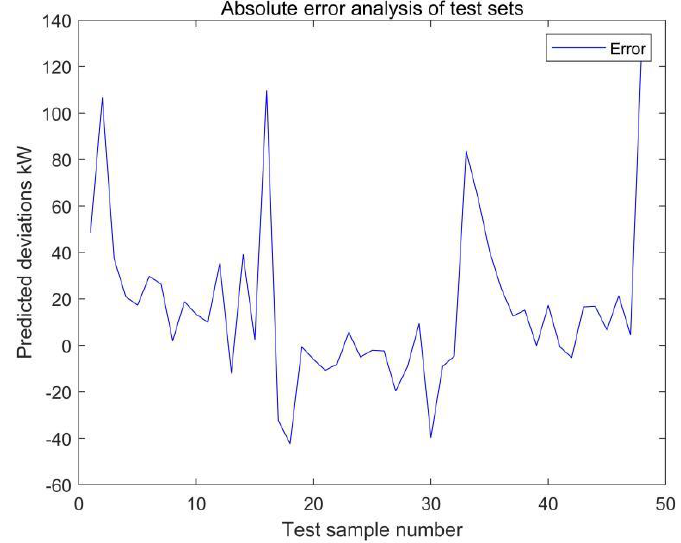
Figure 35. The absolute error of the predicted values of the test set of the 48 test samples remained within 40 kW.